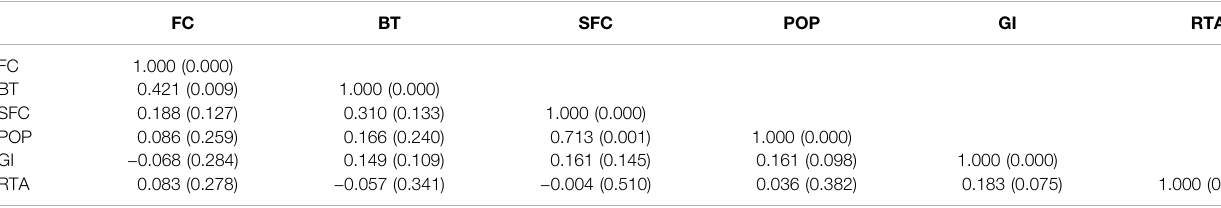
TABLE 7 | Results of QAP regression analysis in 2000. Independent variable Un-stdized